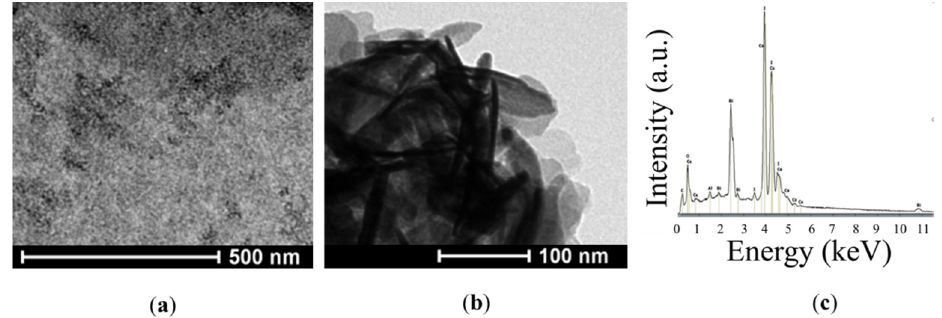
Figure 3. TEM images ( a , b ) and EDX analysis ( c ) of the as-synthesized Cs 3 Bi 2 I 9 powder.